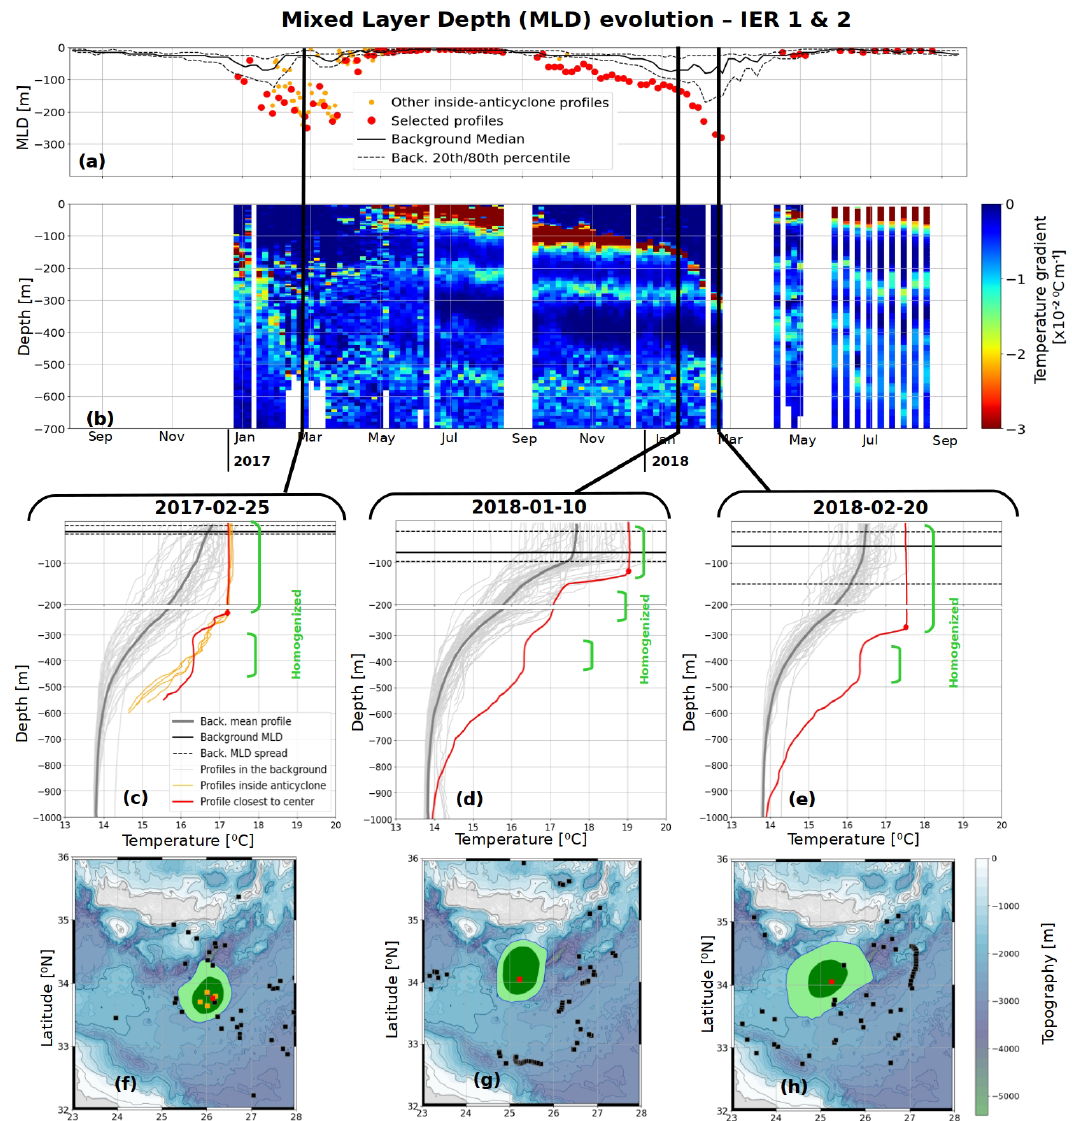
Figure 10. Same colour codes and legend as in Figs. 4 and 5 but for a Ierapetra anticyclone formed in 2016. Three vertical sections show respectively the mixing in early 2017 not reaching the deep subsurface core (c) , the winter in early 2018 with a double core, the shallow core from winter 2017–2018 and the deep core still untouched (d) , and at last the MLD deepening in March 2018 connecting the anomaly formed in March 2017 with the surface (e)